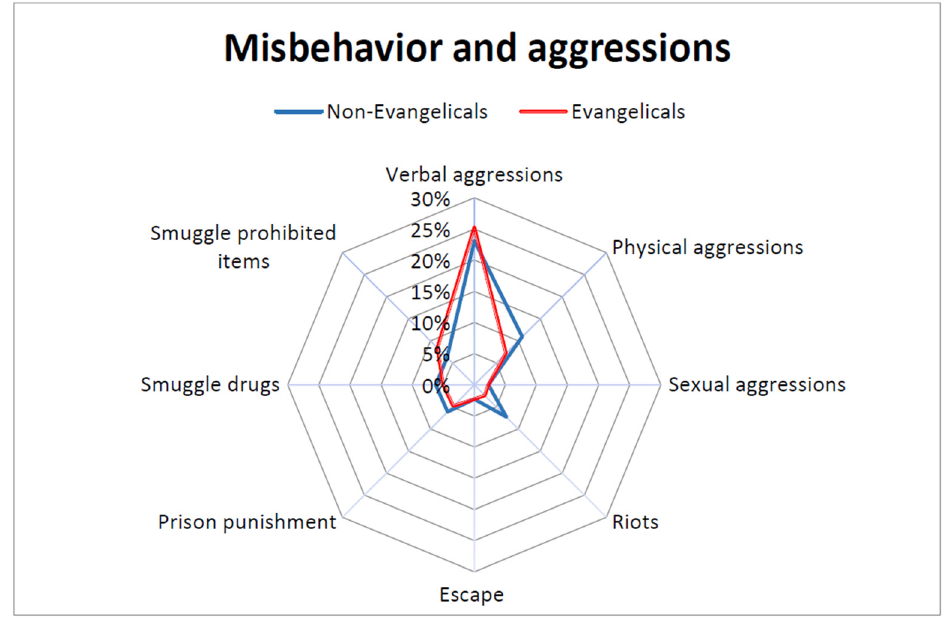
Figure 2. Misbehavior and aggressions. n = 84, n = 84.